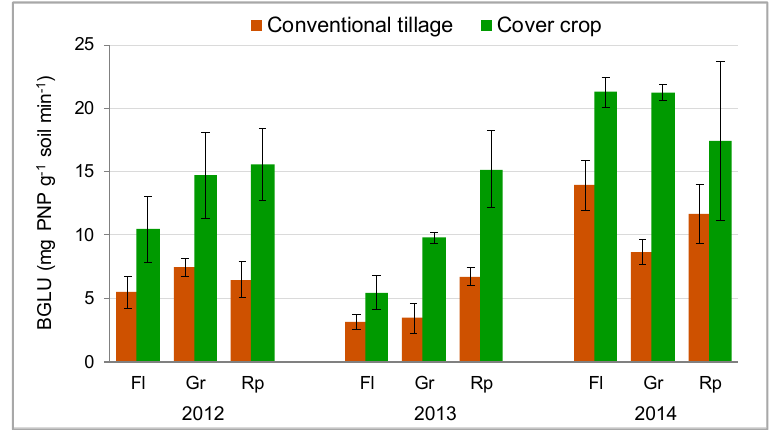
Figure 4. The trend of β -glucosidase activity (BGLU) in soil subjected to conventional tillage or cover crop during flowering (Fl), fruit growth (Gr) and ripening (Rp) in the three years of experimentation. The bar on each column indicates the standard deviation (n = 3).